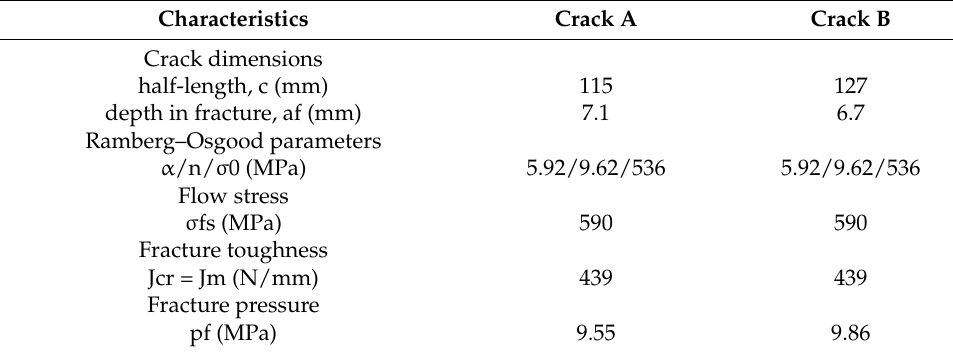
Figure 18. A view of testing pipes in the working pit. Table 3. Some characteristics referring to the pipe segment.